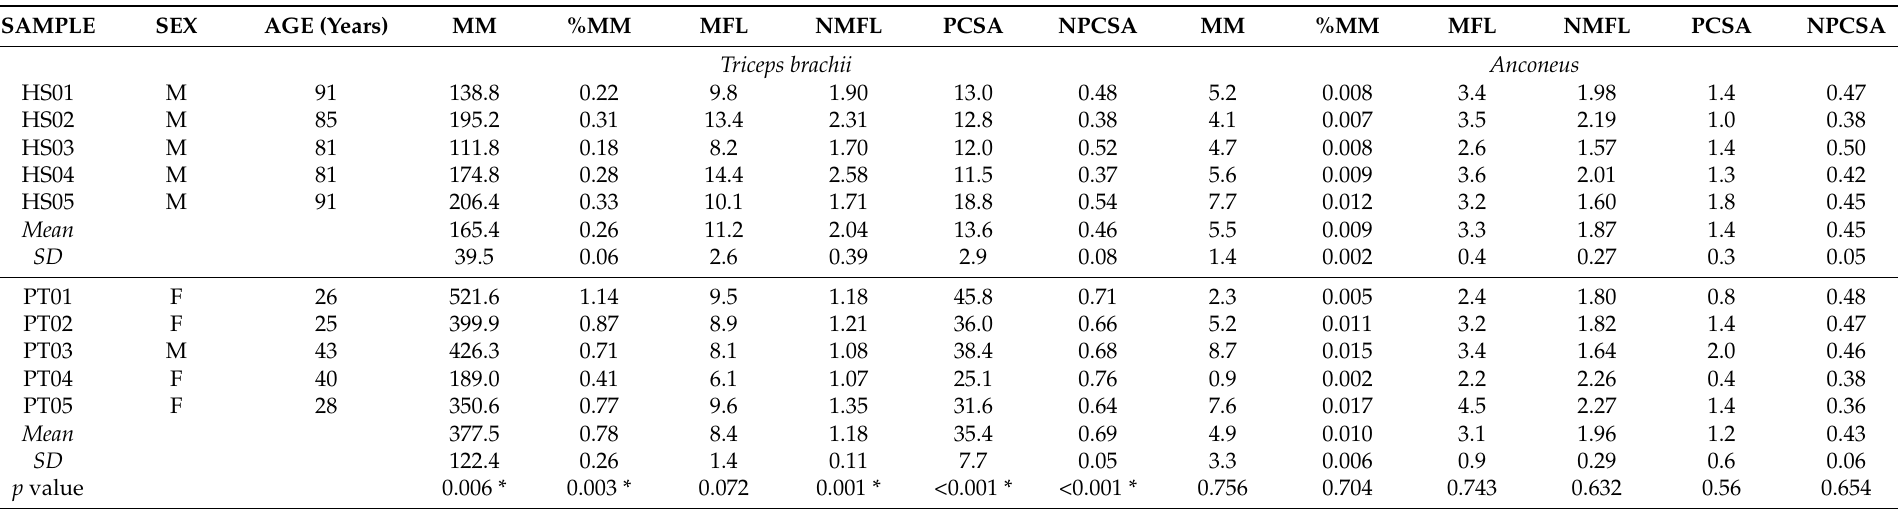
Table 1. Main findings on muscle architecture. MM = muscle mass; %MM = percentage of MM relative to total body mass; MFL = muscle fascicle length in cm; NMFL = normalized muscle fascicle length; PCSA = physiological cross-sectional area in cm 2 ; NPCSA = normalized physiological cross-sectional area; HS = Homo sapiens ; PT = Pan troglodytes ; M = male; F =